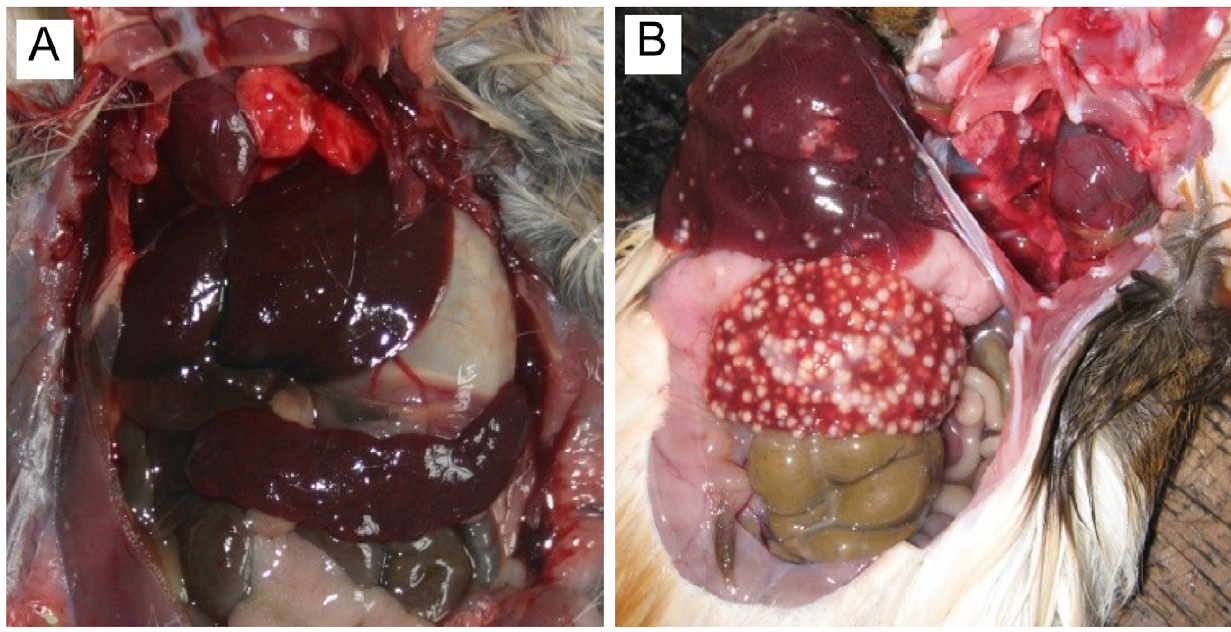
Figure 2. Gross anatomic changes in the liver and spleen of great gerbils (A) and guinea pigs (B). Approximately 7.4 6 10 10 CFU of Y. pestis strain 2505 was injected subcutaneously into the groin of great gerbils, whereas around 5.0 6 10 4 CFU was injected subcutaneously into the groin of guinea pigs. The animals were dissected immediately after death on day 3 p.i. The abscesses are clearly seen on the surface of both the liver and spleen of guinea pigs, but no abscesses were observed on the corresponding organs of great